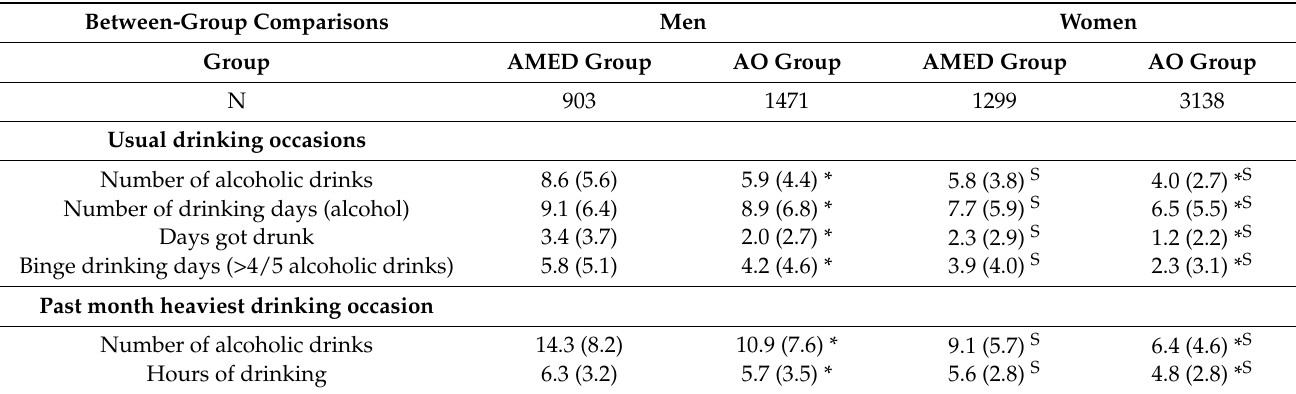
Table 9 summarizes alcohol consumption of AMED and AO consumers. The between- group comparisons reveal that in both men and women AMED consumers reported greater quantity and frequency of alcohol consumption compared to the AO group ( p < 0.001). In